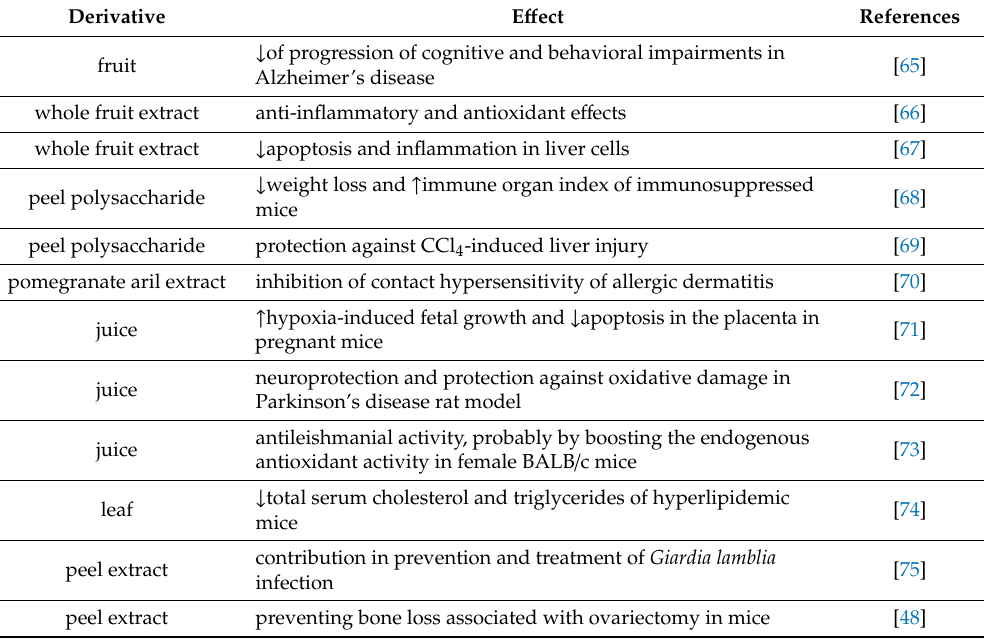
Table 4. Recent health-related pomegranate studies that used mice